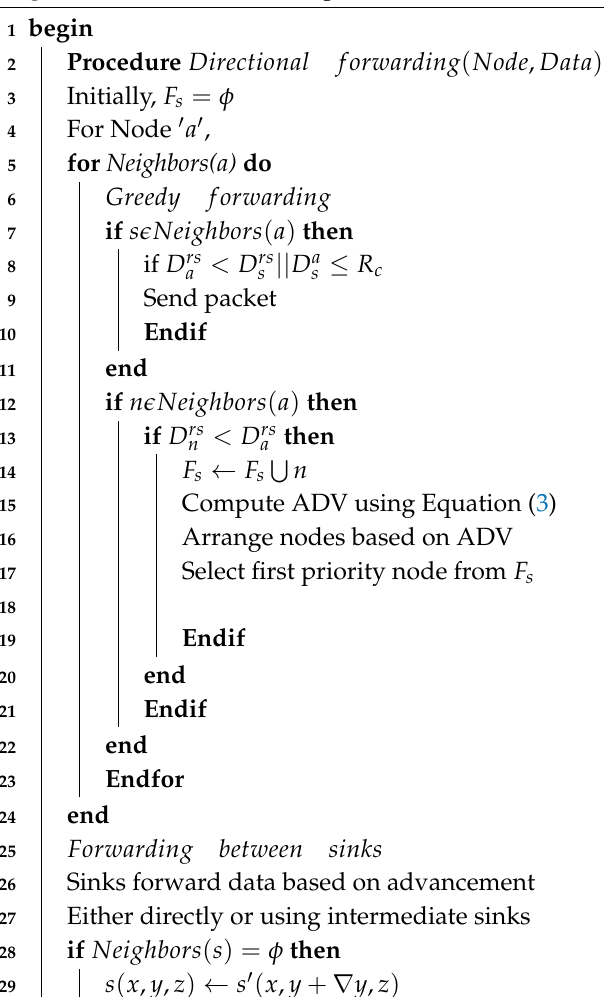
Algorithm 3: Data forwarding mechanism